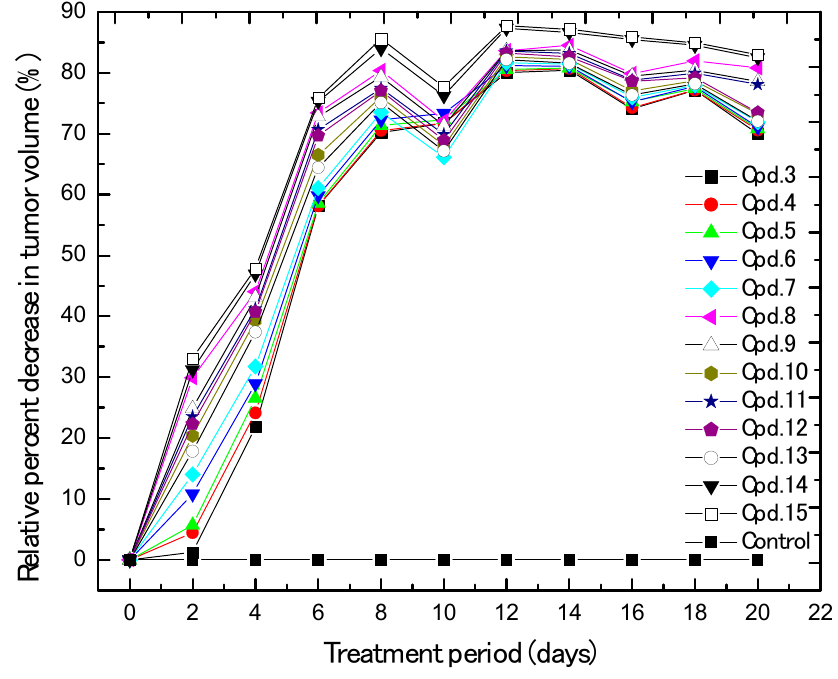
Figure 2. Relative percentage of decrease in tumor volume in response to prepared compounds. Table 1. The average weight of each group of mice treated with drug and the control group. The Provirus Integration in Maloney (Pim) kinases represents a family of constitutively active